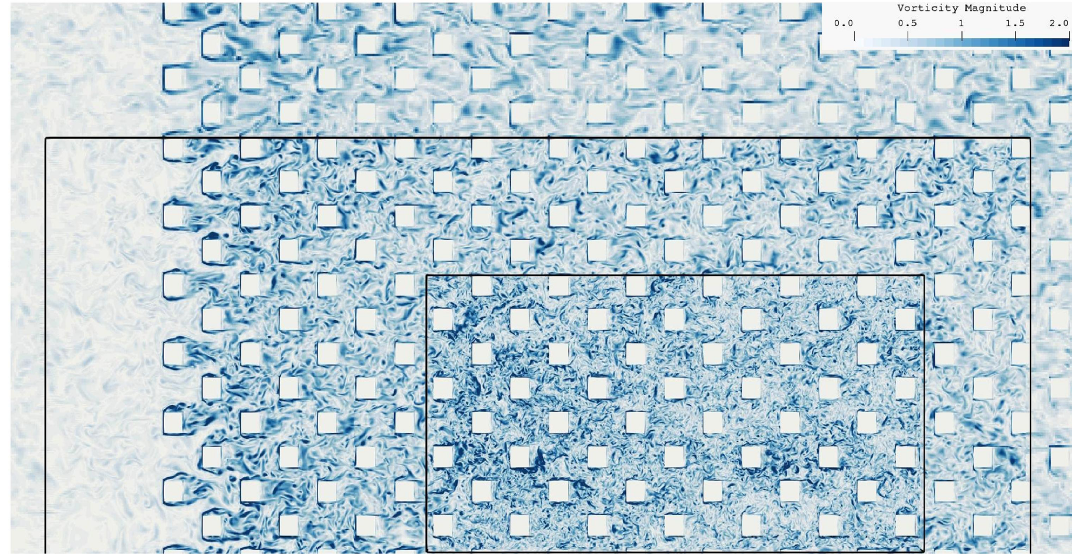
Figure 17. Instantaneous close-up view of vorticity magnitude (s − 1 ) on an x – y plane at elevation z = 0 . 9 H for the v2 case with two nested domains. Black lines indicate the bounds of the first and the second nest. Note that only parts of the domains’ extent are